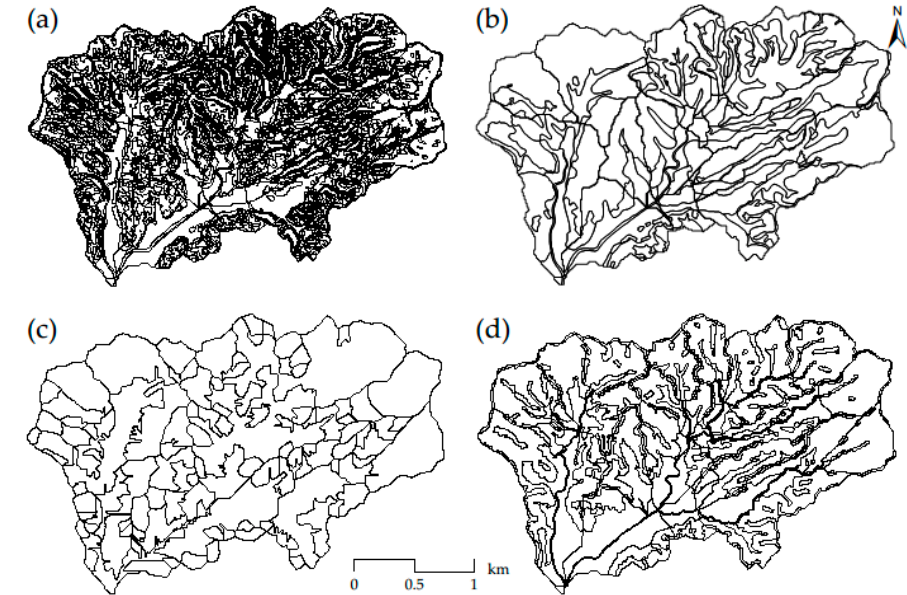
Figure 5. Delineations of BMP configuration units of the Youwuzhen watershed: ( a ) HRUs; ( b ) spatially explicit HRUs; ( c ) hydrologically connected fields; ( d ) slope position units.